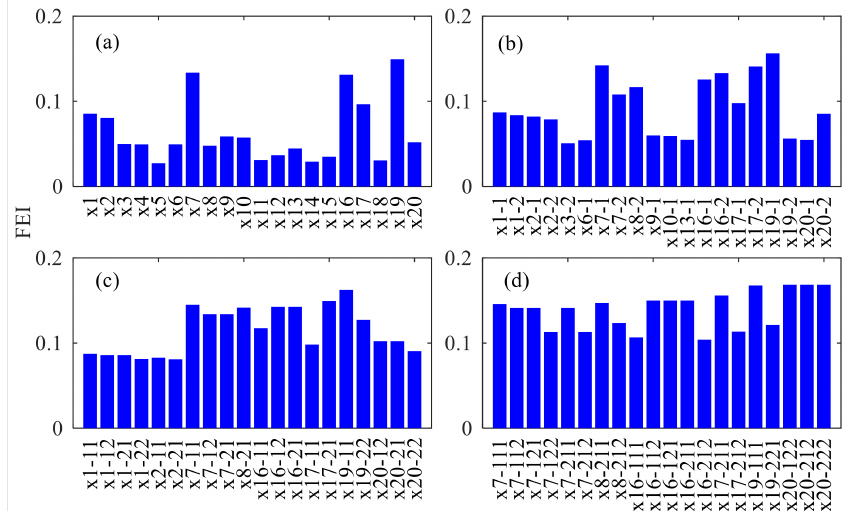
Figure 16. Denoising process based on IMRSVD for gear with breakage: ( a ) pre-decomposition,